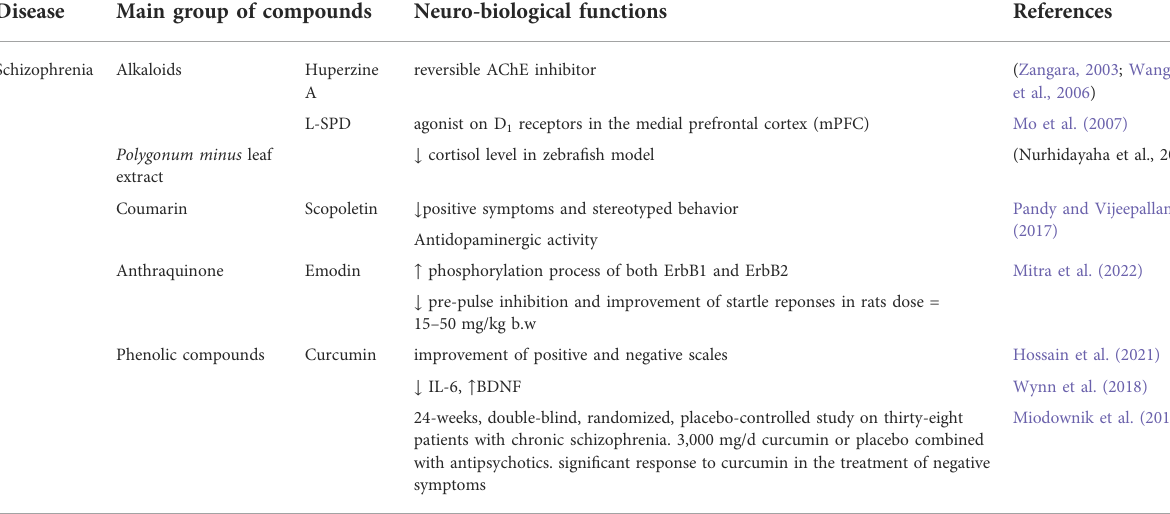
TABLE 3 The most representative bioactive compounds and their major effects in treatment and prevention of schizophrenia.